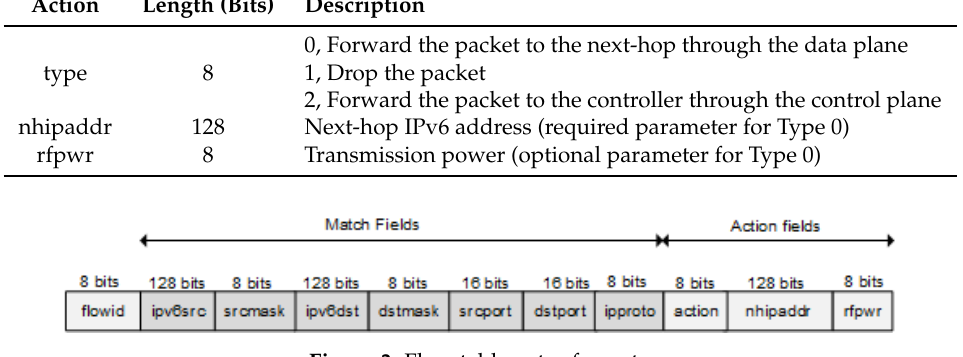
Figure 3. Flow table entry